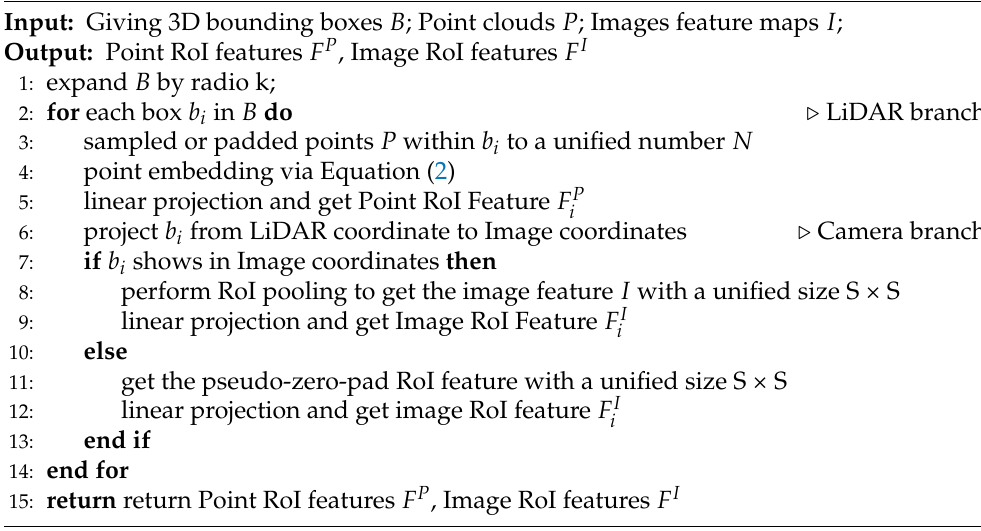
Algorithm A1 Proposed RoI Feature Extractor in